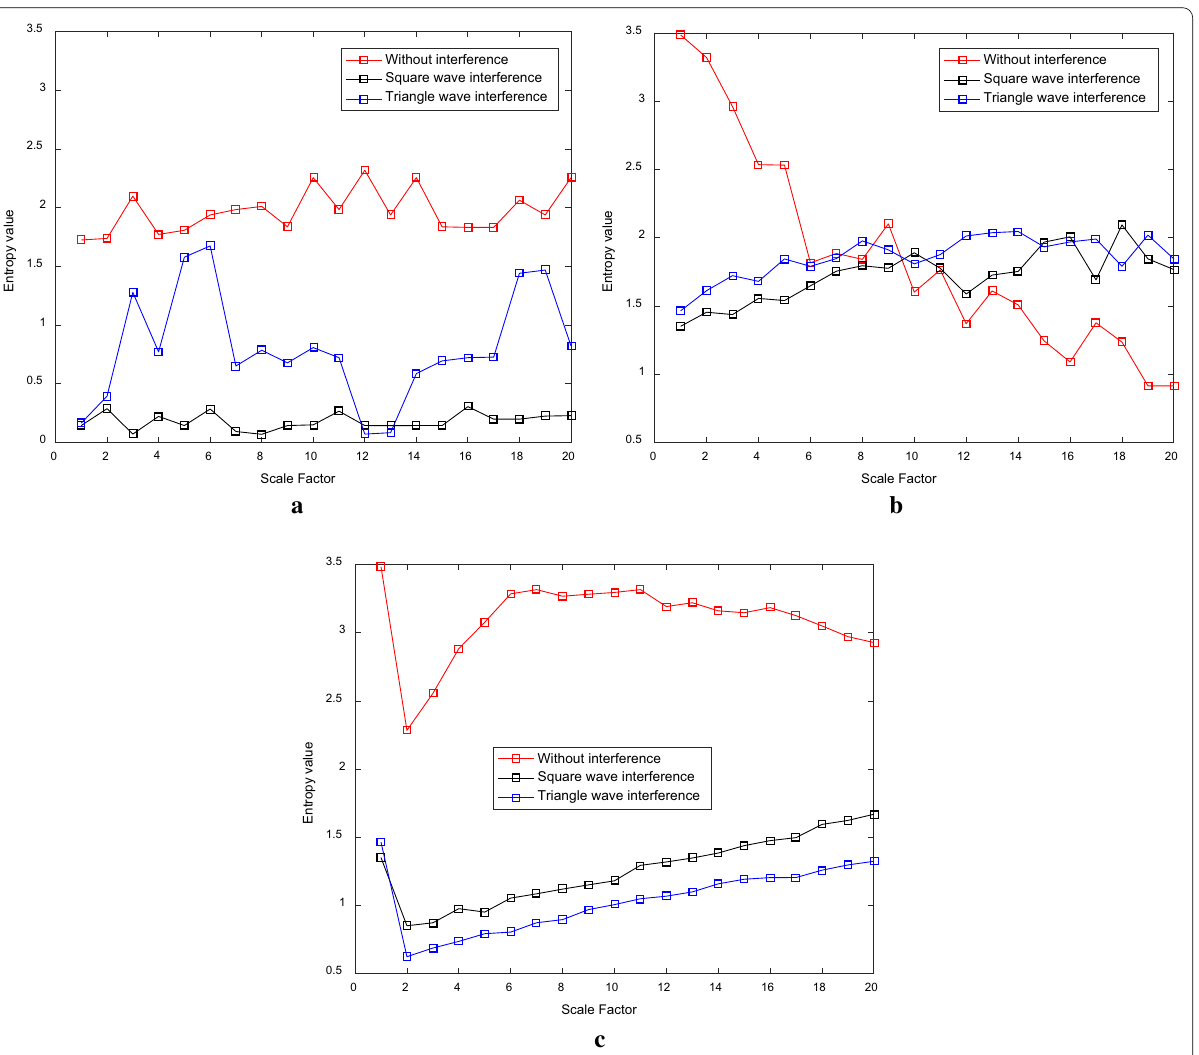
Fig. 1 The results obtained for a the ME, b MDE and c RCMDE using a set of sample library signals at different scale factors; the abscissa represents the scale factor τ , and the ordinate represents the entropy value at the corresponding